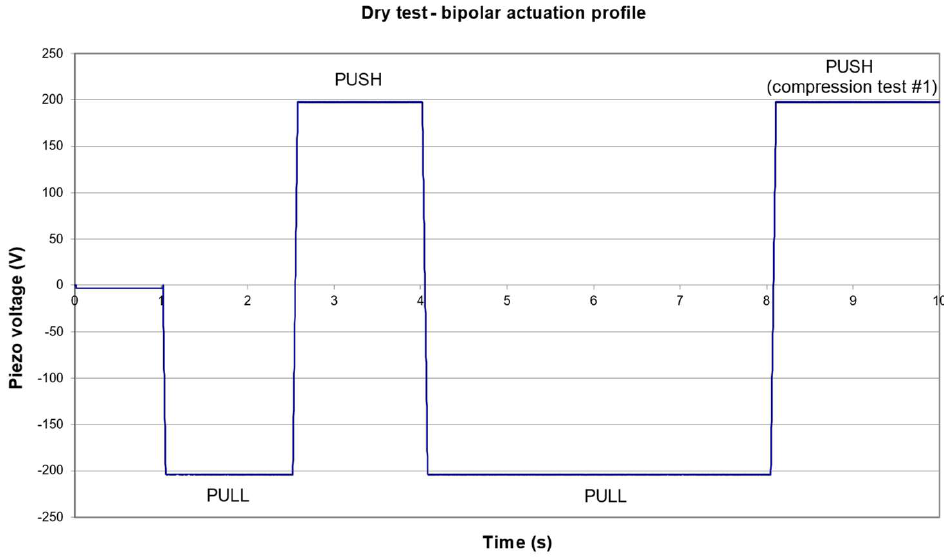
Figure 9. Bipolar actuation profile of the piezo actuator during the dry test sequence.